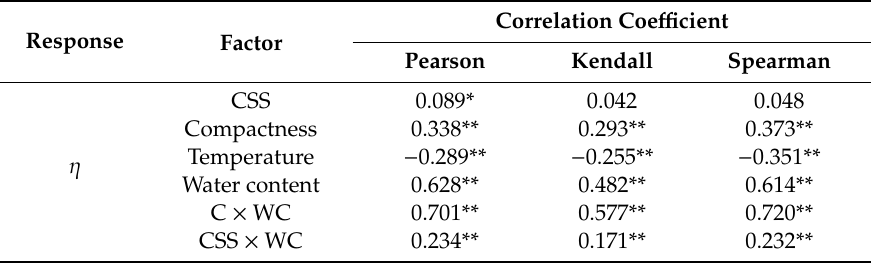
Table 7. Correlation coe ffi cients between η and various factors.